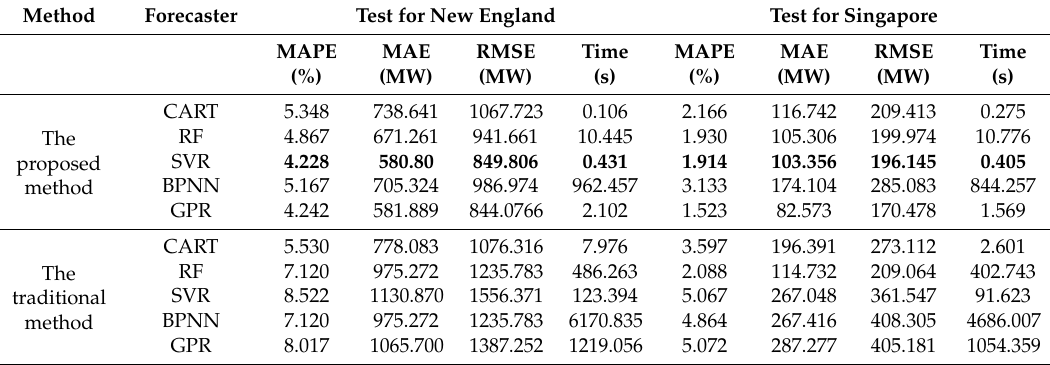
Table 14. Comparison of the error of different forecasting approaches with original feature set.